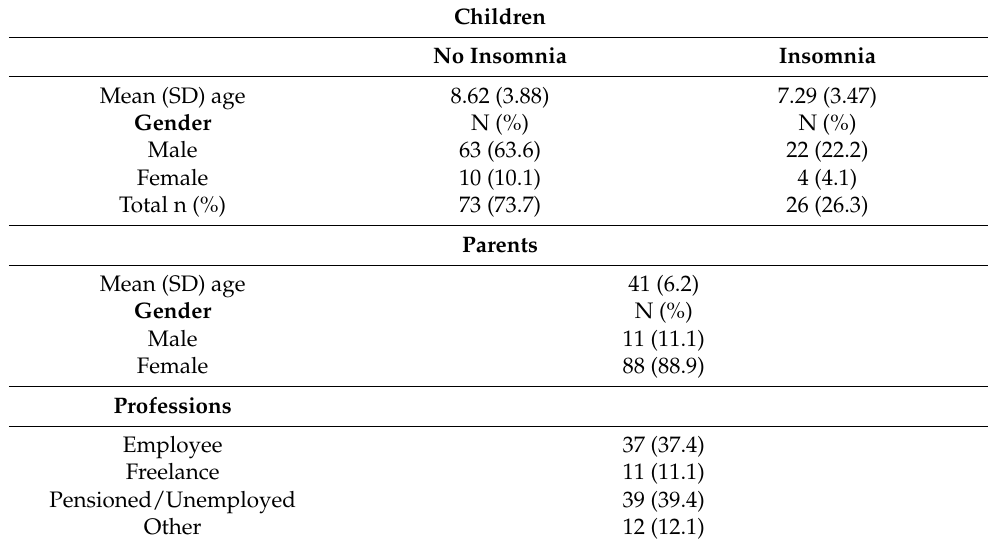
Table 1. Sample characteristics.